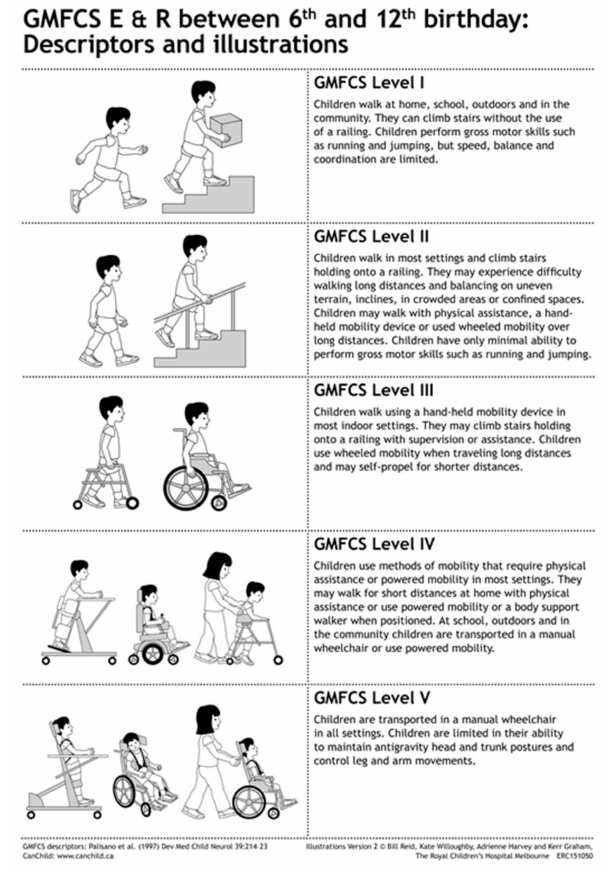
Figure 1. Five Gross Motor Function Classification System (GMFCS) Expanded and Revised levels, as depicted for children ages 6–12 years. Reproduced with permission